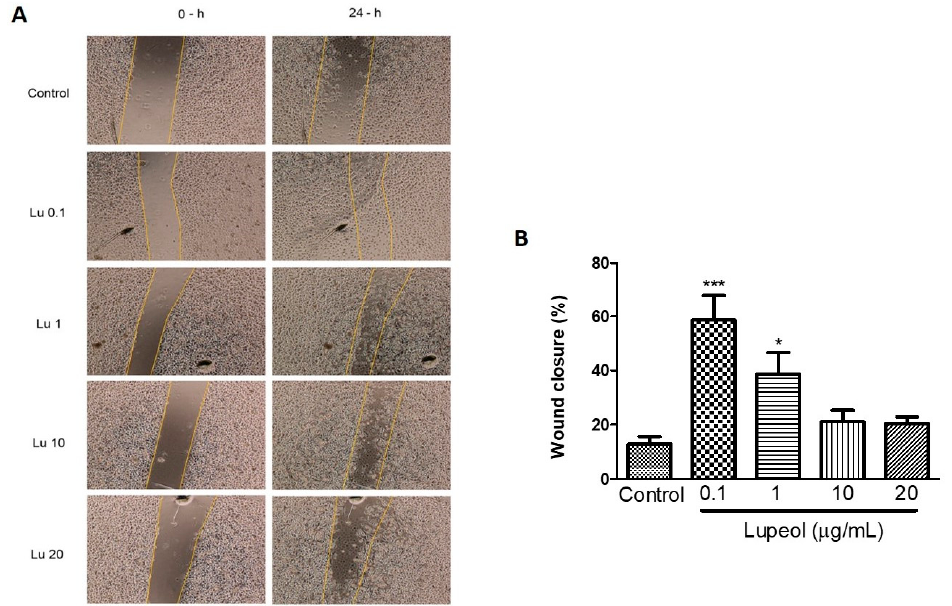
Figure 3. Wound healing effect of lupeol on human epidermal keratinocytes in the scratch assay after 24 h incubation. Cells were incubated with lupeol at concentrations of 0.1, 1, 10, and 20 µ g/mL or DMSO at 10 µ g/mL as a negative control. ( A ) Representative images of scratch assay at 0 and 24 h. Lu: lupeol. ( B ) Dose-response effect of lupeol on wound closure. Data are expressed as mean ± standard error of the mean (SEM). * p < 0.05 and *** p < 0.001 versus control